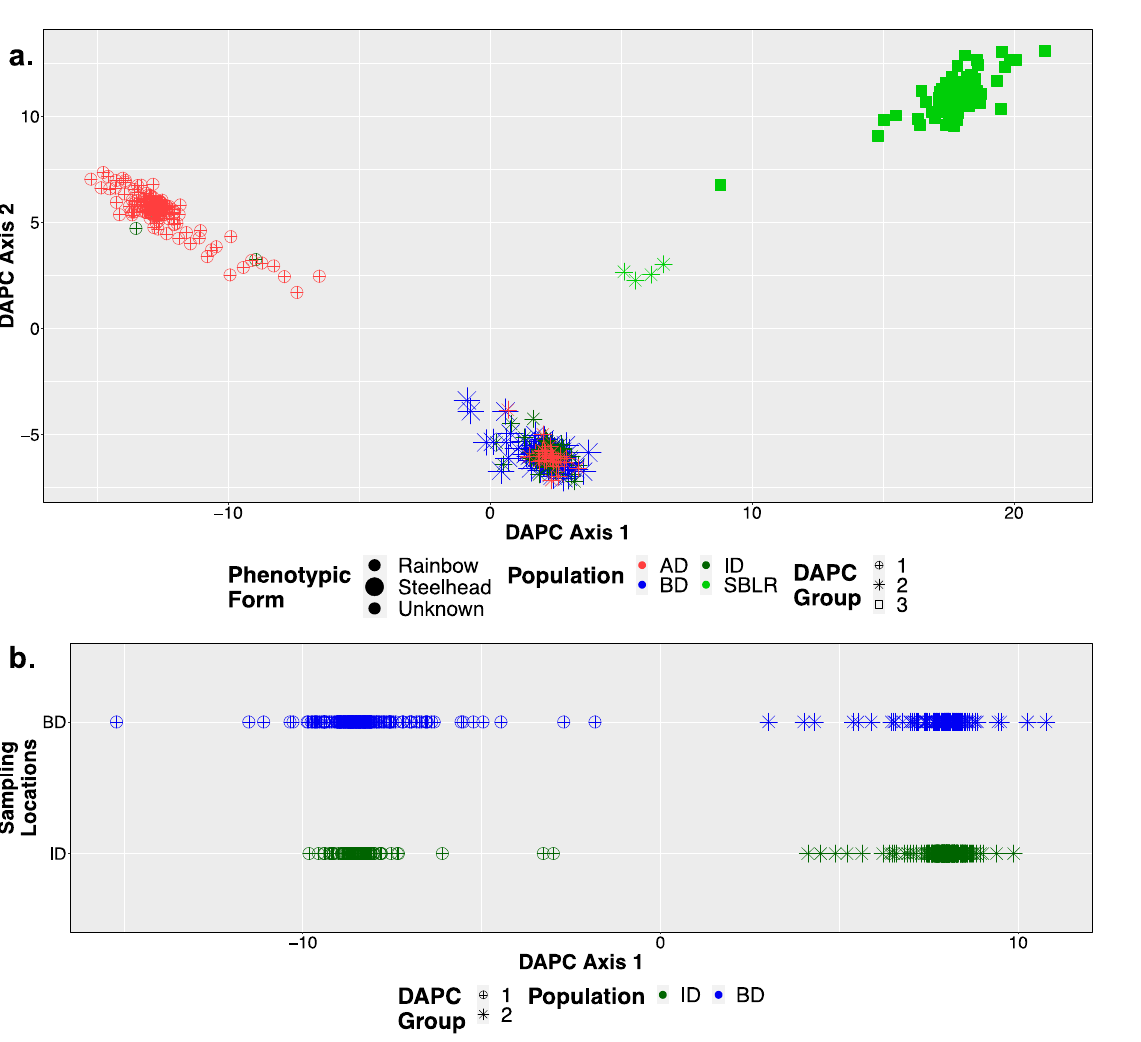
Figure 2. DAPC supported K = 3 genetic clusters prior to dam removal ( a ) and K = 2 genetic clusters following dam removal ( b ), note the points are split by sampling location for visualization. Shapes were indicative of population assignment by DAPC (DAPC Group) and color was based on population. Larger points in ( a ) were indicative of the steelhead life history phenotypic form while smaller points were indicative of the resident rainbow trout form or fish that could not be categorized in either form.